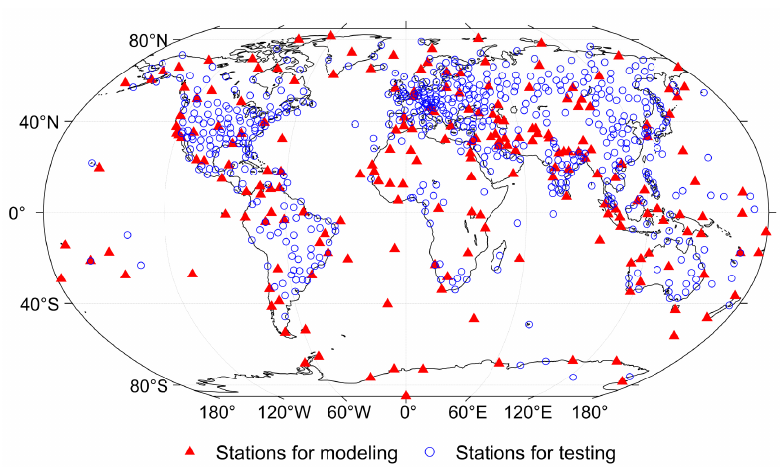
Figure 1. The distribution of IGRA stations used in this work.